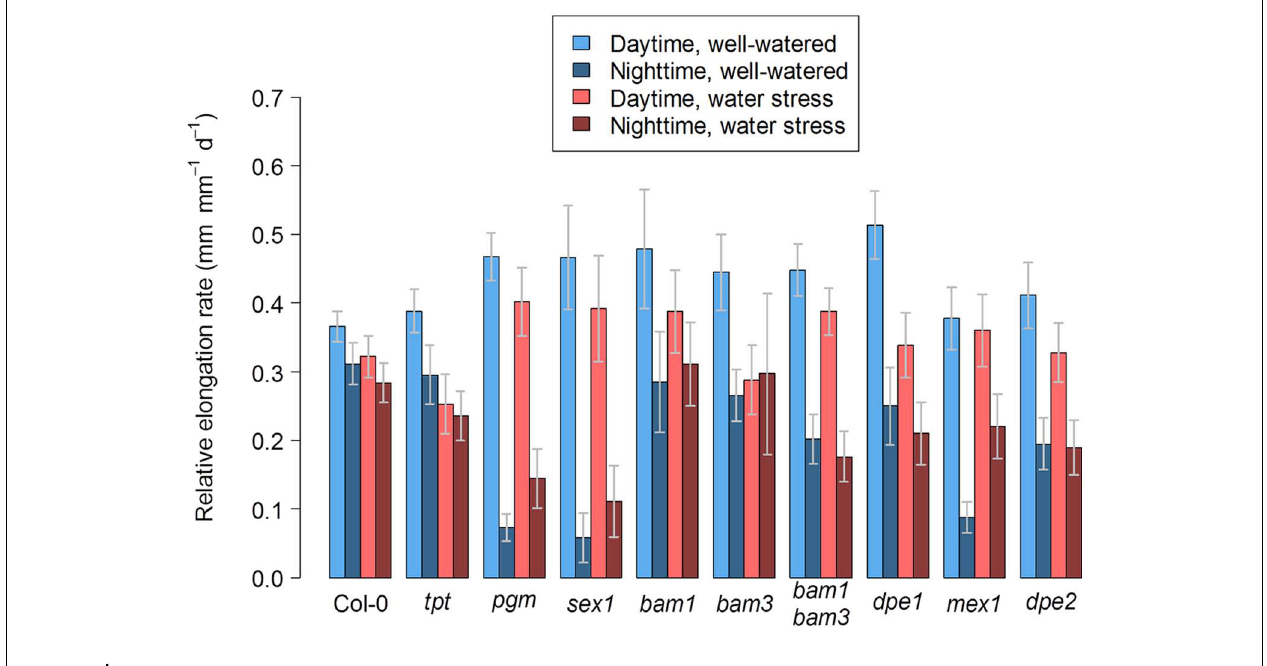
for the days 4, 5, and 6 following emergence of the sixth leaf under well-watered conditions or under moderate soil water stress. Error bars are 95% confidence